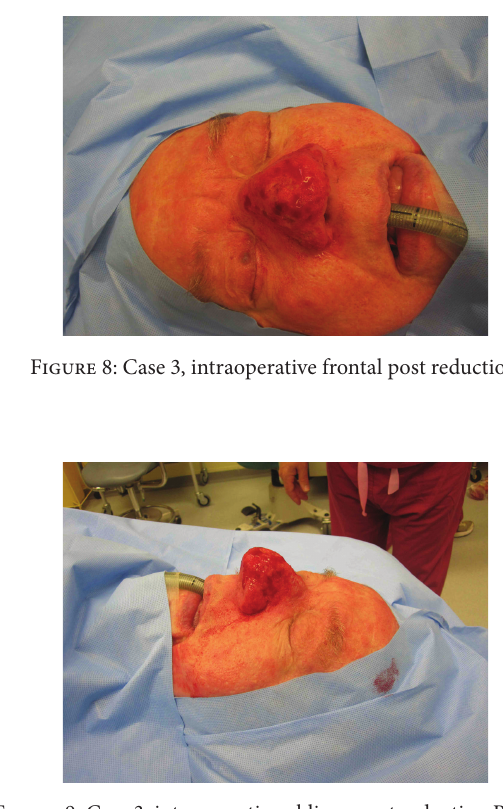
Figure 9: Case 3, intraoperative oblique post reduction